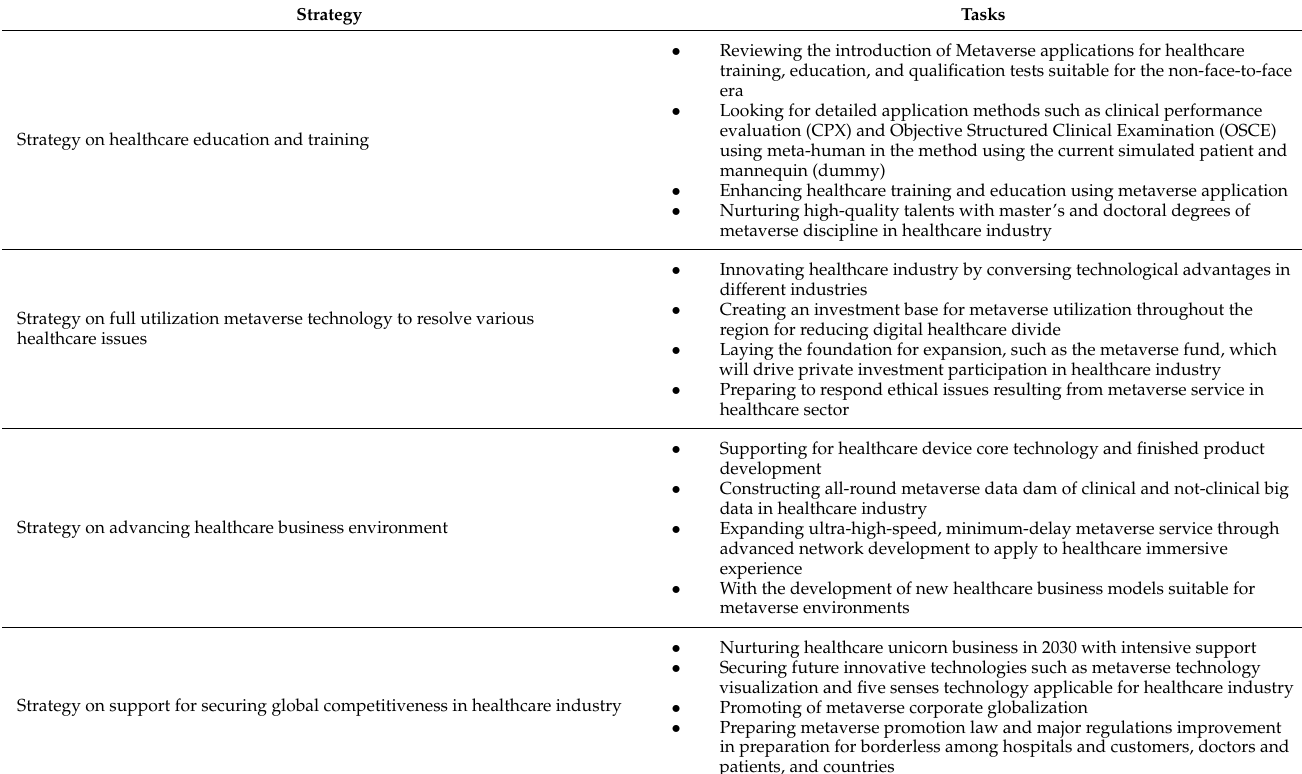
Table 5. Strategies and tasks for the metaverse service development in healthcare